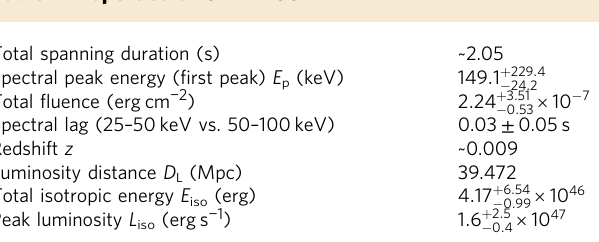
Table 1 Properties of GRB 170817A Total spanning duration (s)